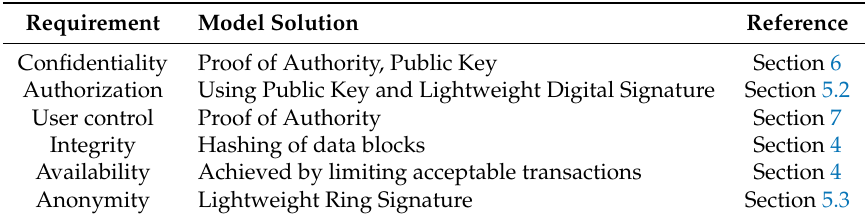
Table 2. Security Requirement